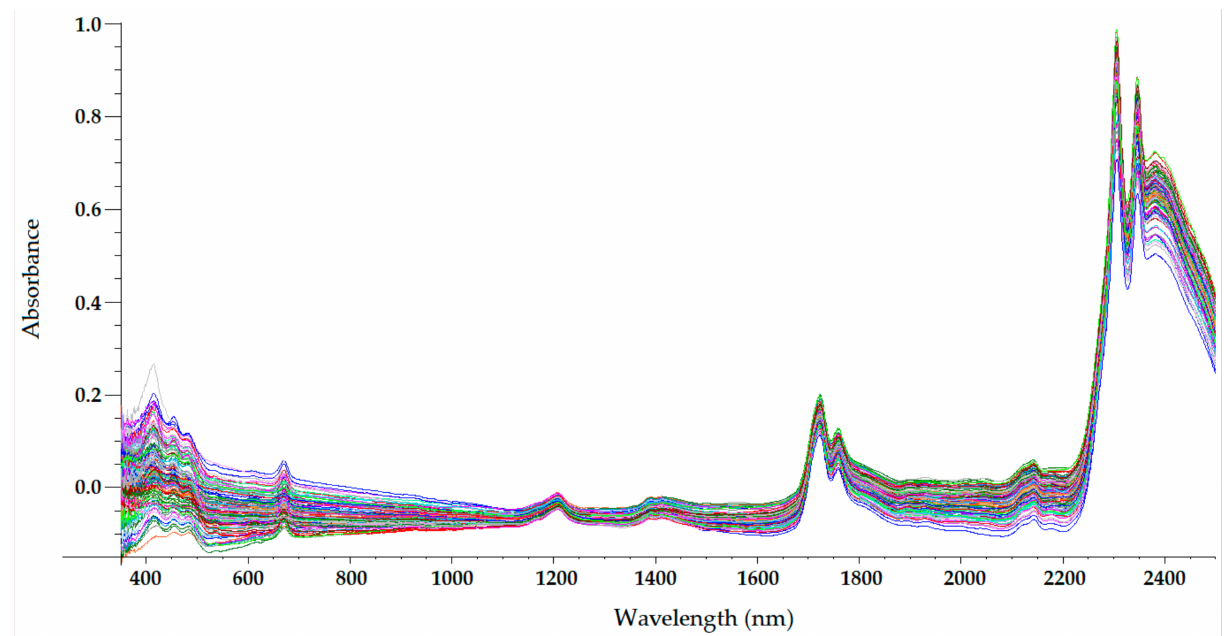
Figure 3. Mean-normalized visible/NIR spectra of 127 olive oils obtained with 0.5-mm path-length quartz cuvette [22].